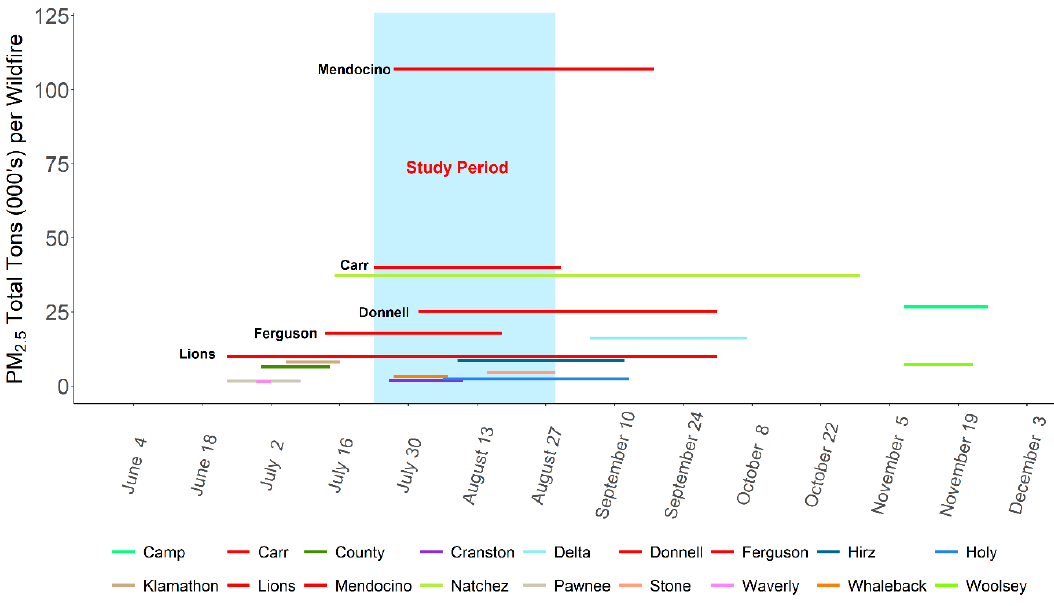
Figure 3. Estimated total emissions (PM 2.5 total tons per wildfire) and the active time of fire spread per fire between 4 June and 3 December 2018, for 18 fires. Fires included in this study have red lines. The study period (time period in which smoke apportionment modeling was performed) is shaded in light